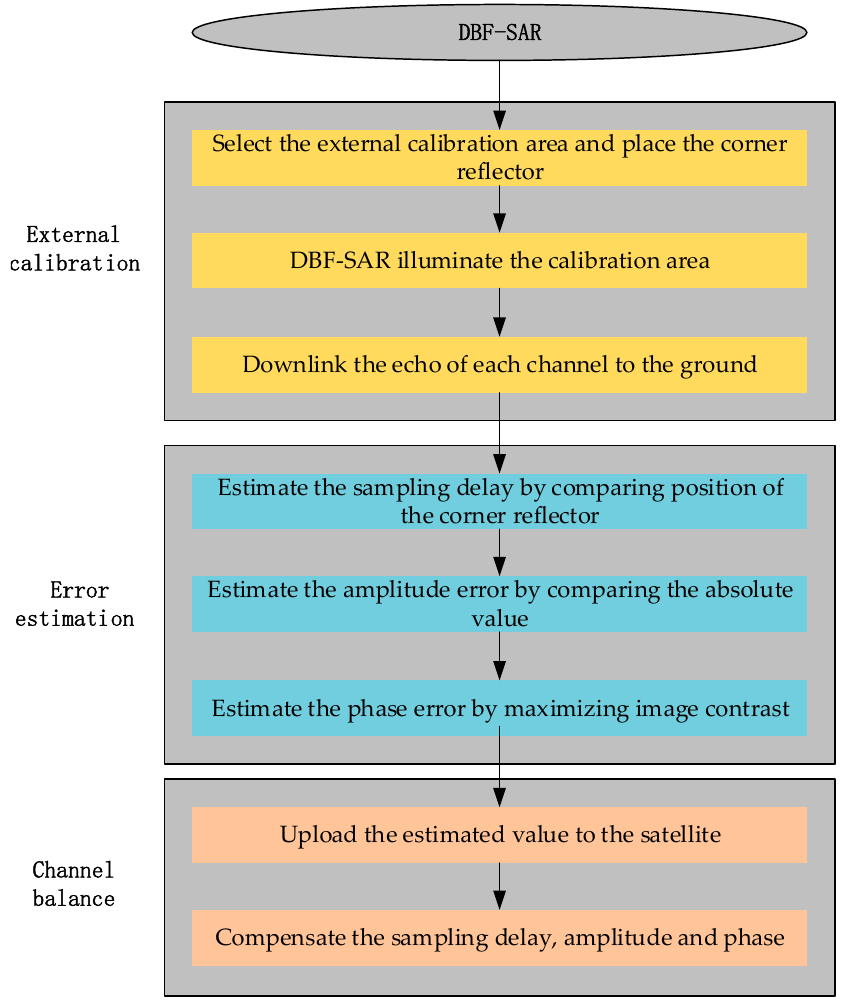
Figure 4. Workflow of the proposed method.